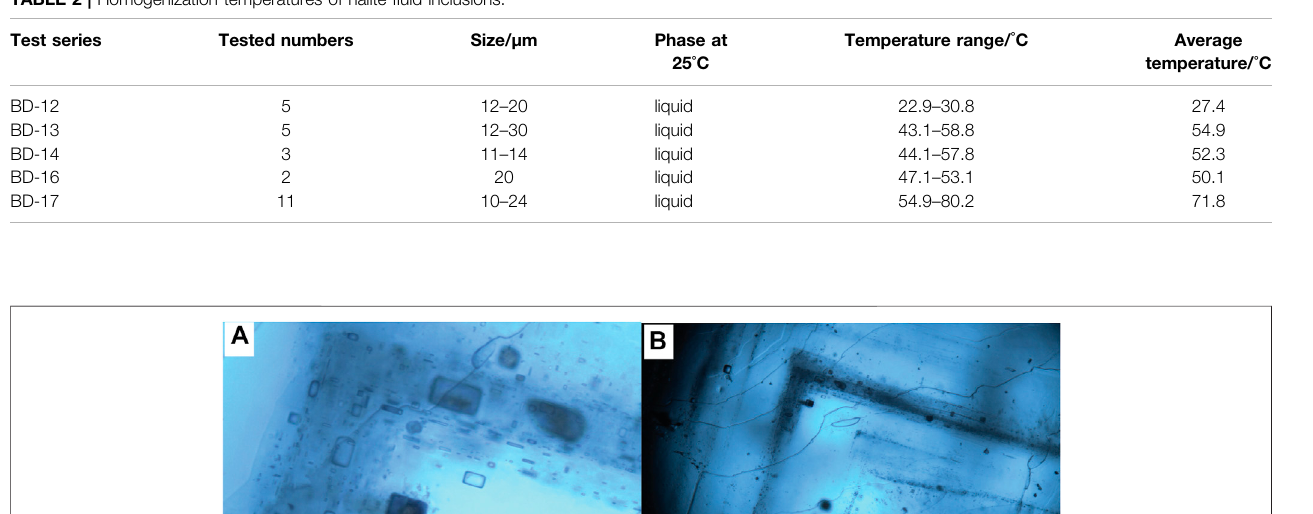
Frontiers in Earth Science |